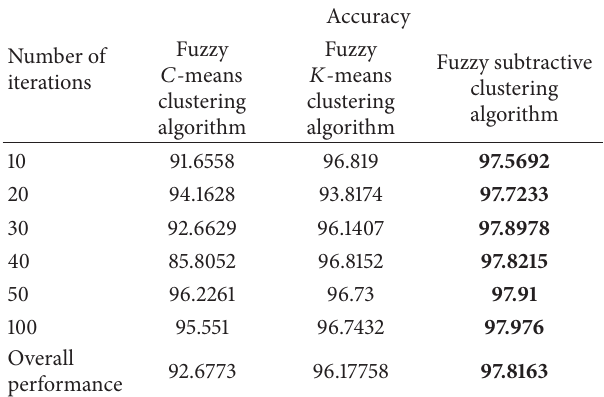
Table 1: Accuracy of the three fuzzy clustering algorithms for data 1.